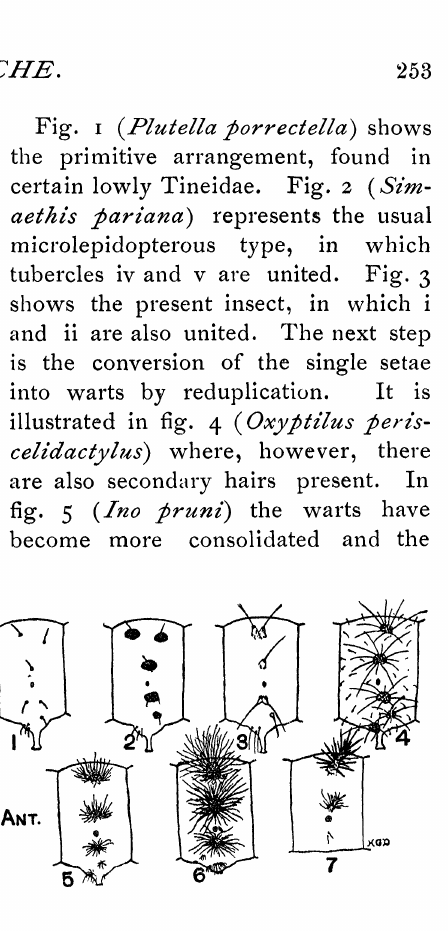
Fig. 2 (Sire- Fig. 3